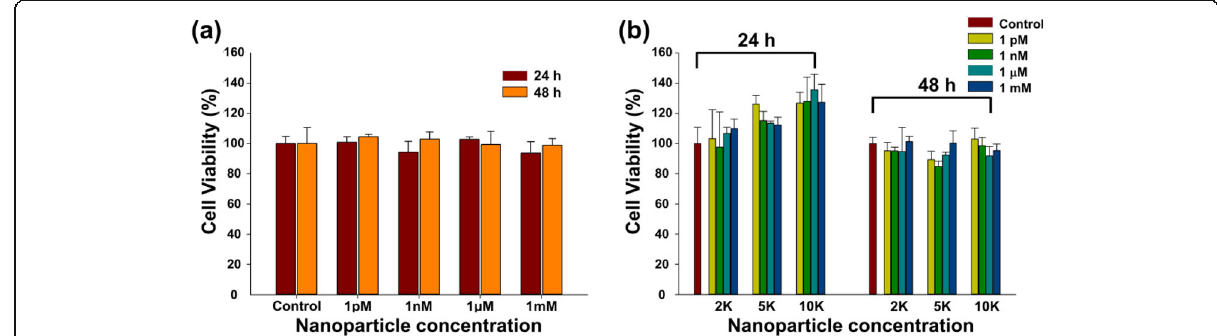
Fig. 4 Viabilities of CT26 mucin cells treated with bare Fe 3 O 4 -Au core-shell NPs and surface-modified Fe 3 O 4 -Au NPs at different concentrations. a Fe